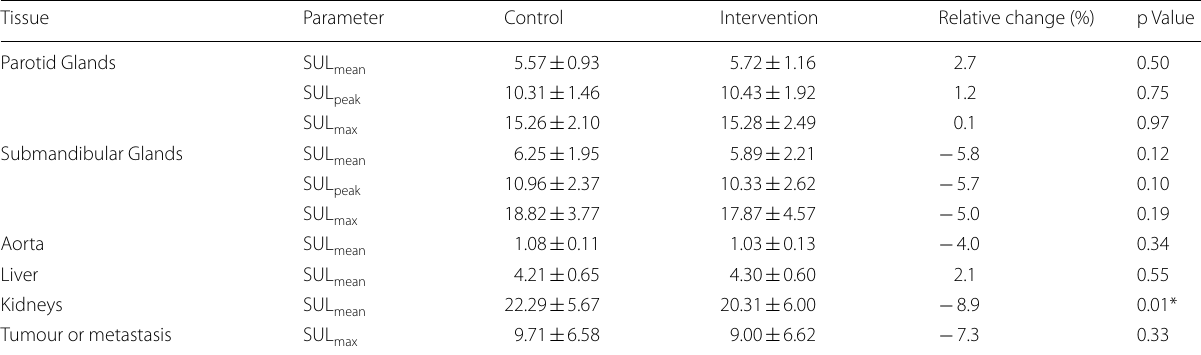
SUL Standardised uptake value corrected for lean body mass corrected; *p < 0.05 is considered statistically significant =